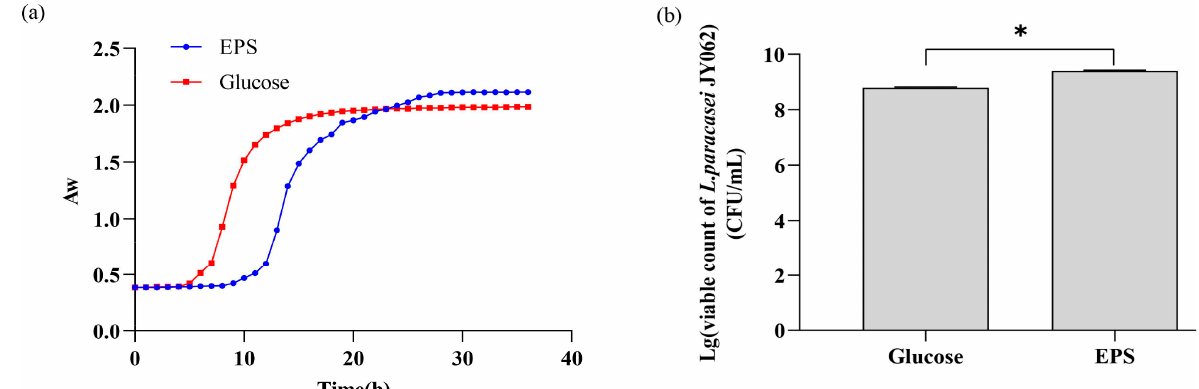
Figure 1. ( a ) Growth curves of L. paracasei JY062 in medium supplemented with glucose and EPS (2%), respectively; ( b ) viable count of L. paracasei JY062 in EPS medium and glucose medium. * p < 0.05 as compared to glucose.